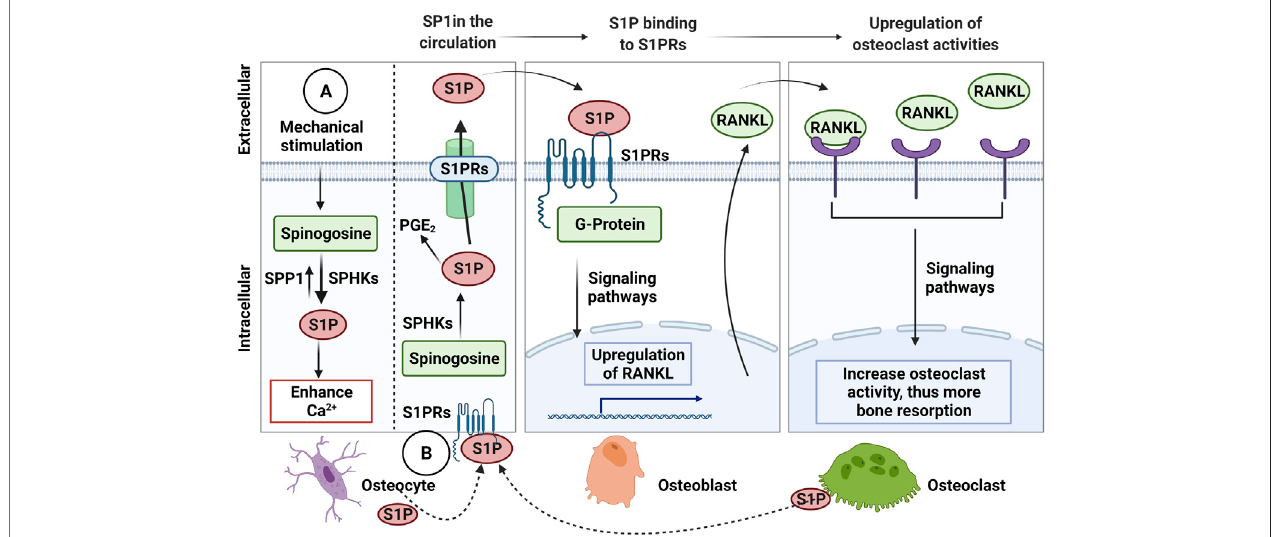
FIGURE3| TheSphingosine-1-Phosphate(S1P)signallinginosteocyticmechanotransductionandeffectsofosteocyte-mediatedextracellularS1Ponosteoblast- osteoclast crosstalk. (A) The endogenous S1P production in response to mechanical stimulation from Sphinogosine by the S1P phosphohydrolase (SPP1) and sphinogosine kinase (SPHKS) leading to increased cellular Ca 2+ . (B) S1P can be released by osteocytes, which extracellular S1P can bind to S1P receptors (S1PRs) on osteoblaststhatactivatesignalingpathwaystoupregulatereceptoractivatorNF- κ B(RANKL).Then,osteoblastsreleaseRANKLthatbindstoRANKonosteoclasts to increase osteoclast activity for bone resorption. Osteoclasts are also known to release S1P, which binds to S1PRs on osteocytes as a feedback loop to increase intracellular S1P and prostaglandin E2 (PGE 2 ), Receptor activator NF- κ B (RANKL), ligand (RANKL). Figure created using BioRender.